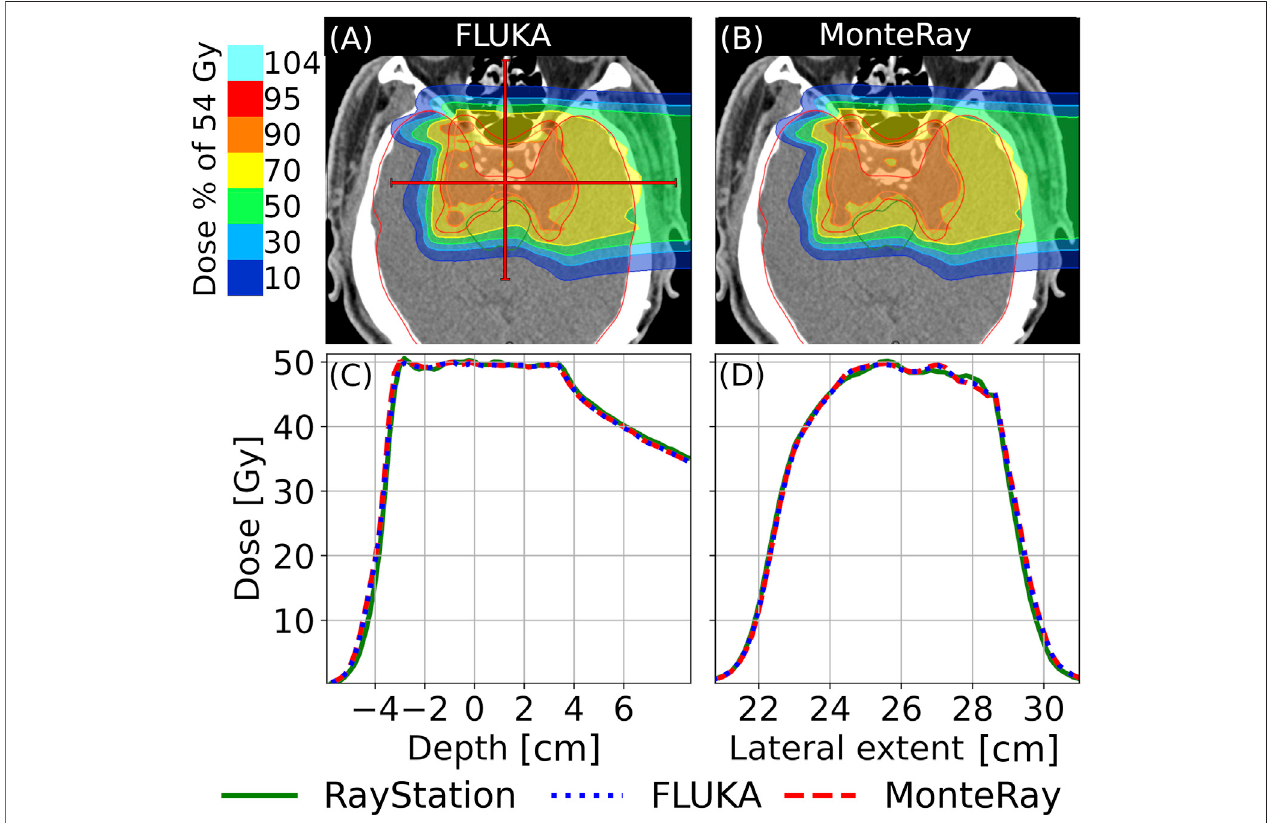
FIGURE 6 | Axial views of calculated doses for the plan described in Section 2.2.4 are shown for (A) FLUKA and (B) MonteRay. In panels (C) and (D) , longitudinal andlateralpro fi lesareshown,respectively.Thelocationsofthepro fi lesrelativetothe2Dplotsareindicatedtroughredlinesinpanel (A) .RayStationpro fi lesareindicated by a solid green line, FLUKA pro fi les by a dotted blue line and MonteRay pro fi les by a dashed red line.